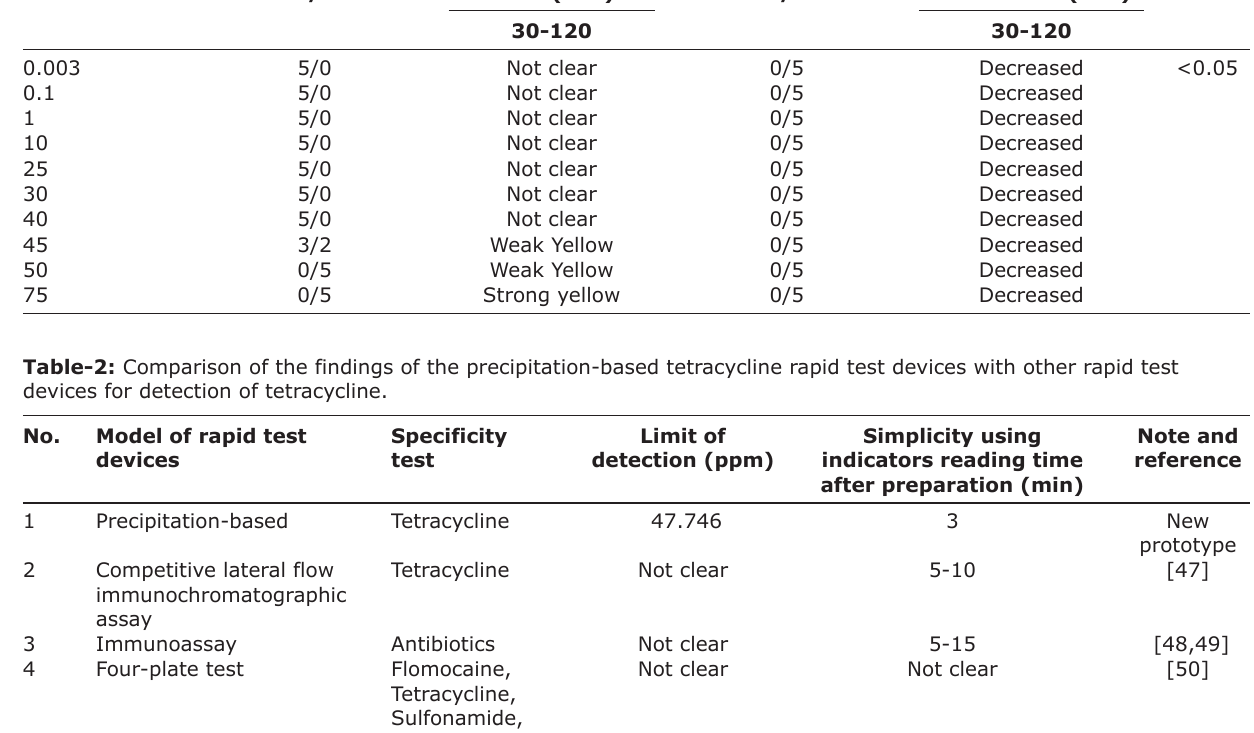
Table-1: Observation limit of detection and detected tetracycline pharmaceutic grade in samples using rapid test devices at five samples. Concentrate ( μ g/mL) ( X